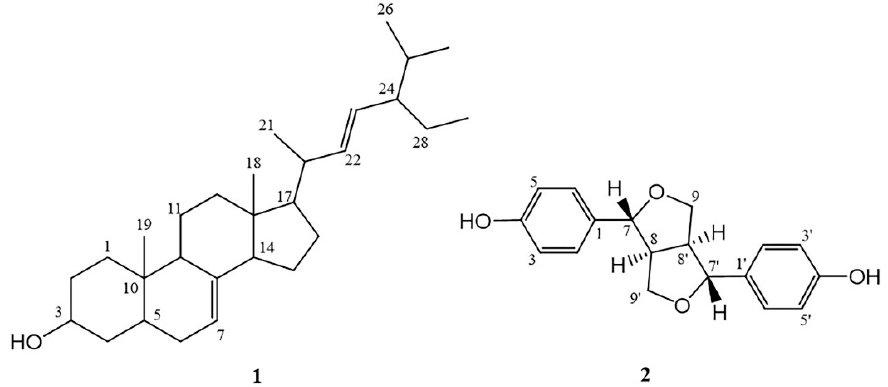
Table 2. The fatty acids identified from the MC stem extracts by GC/FID analysis.